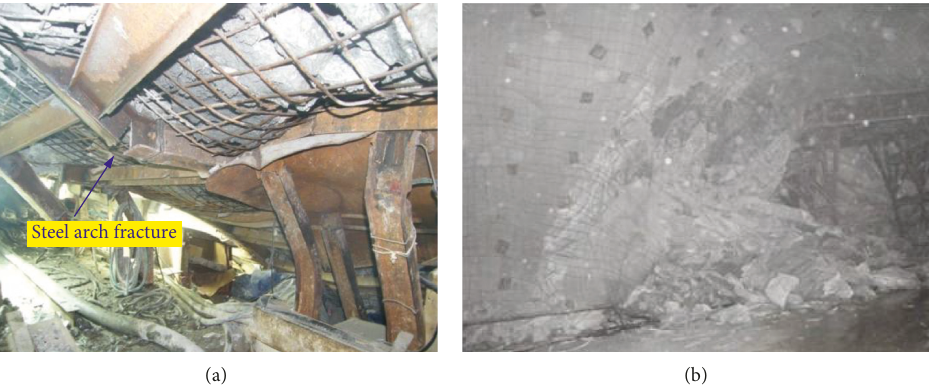
Figure 1: Support failure triggers rockburst at the Jinping II Hydropower Station in (a) diversion tunnel #2 and (b) diversion tunnel #4 [6].